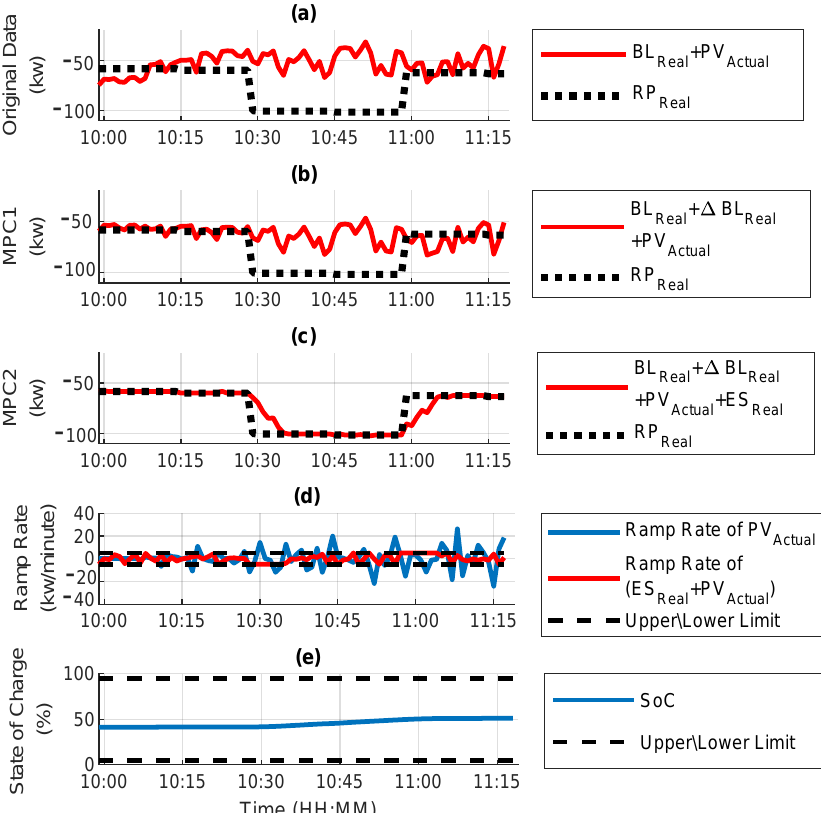
Figure 13. Scenario 1—algorithm performance for real power ( a ) original data, ( b ) MPC1 simulation result, ( c ) MPC2 simulation results, ( d ) ramp rate constraint, and ( e ) energy storage SoC constraint.